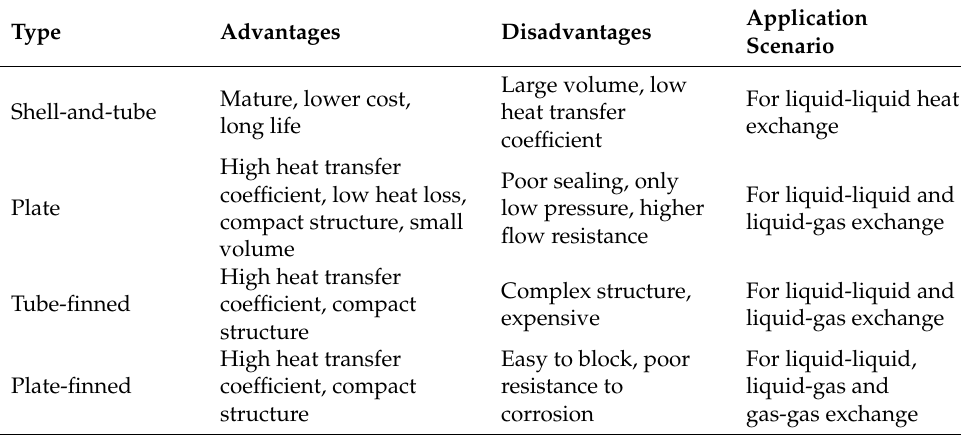
Table 5. Comparison of different heat